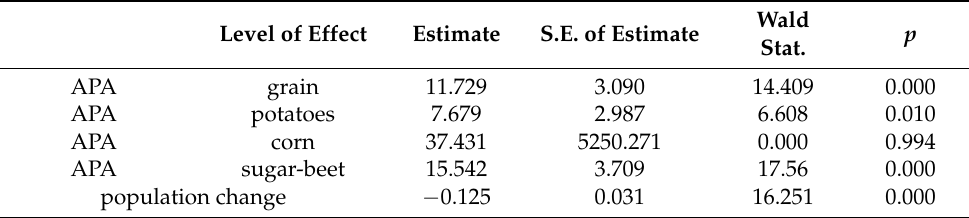
Table 6. Testing of regression estimates for a high-high concentration of post-agricultural brownfields established after the year 2004.